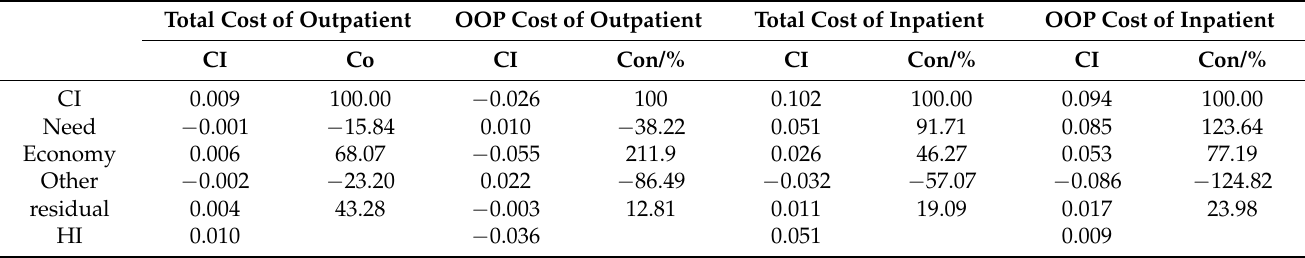
Table 9. Horizontal index of the total cost and OOP of two-week outpatient and inpatient among rural migrant workers with